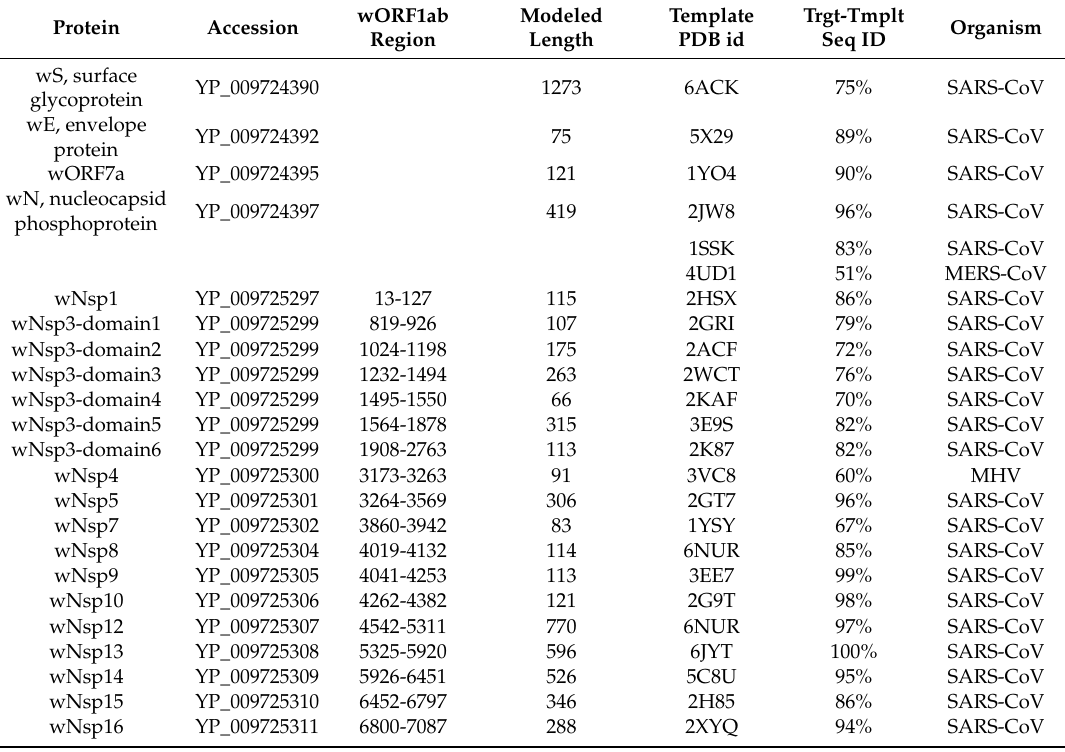
Table 1. The list of SARS-CoV-2 proteins analyzed and structurally characterized in this